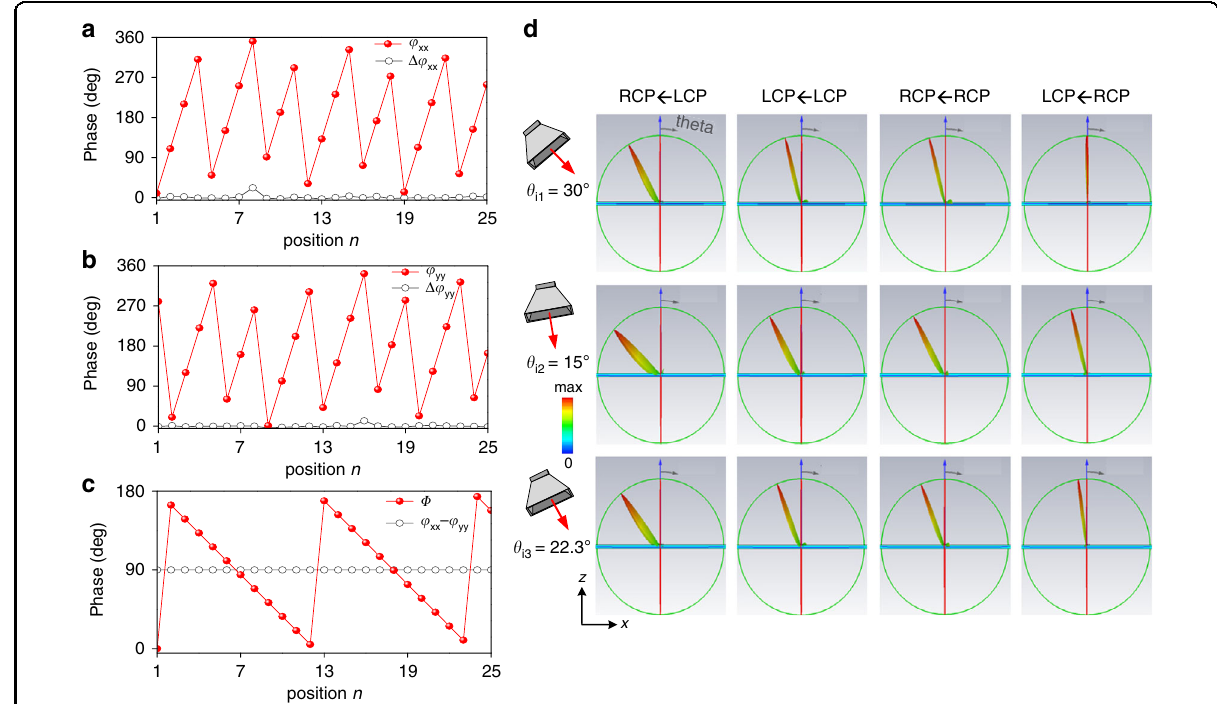
Fig. 4 FDTD characterization of the spin-and-momentum multiplexed retrore fl ector. Synthesized birefringent dynamic phases φ xx and b φ yy of fi nally utilized meta-atoms, and practical near-zero phase tolerance pro fi le of Δ φ Δ φ Δ φ xx and yy are deviations between theoretically calculated phases and those of practically utilized meta-atoms, indicating negligible phase errors. c Required half geometric phase, and phase difference between φ xx and φ yy . d FDTD calculated 3D scattering patterns under three different incidences at four channels by altering orthogonal CP states of incident and output